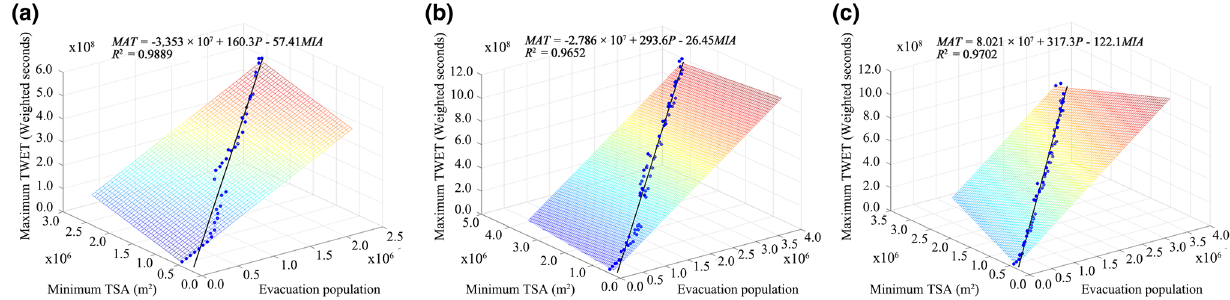
Fig. 9 Fitting surfaces of maximum total weighted evacuation time (MAT), minimum total shelter area (MIA), and evacuation population. a – c Location 1, Location 2, and Location 3,